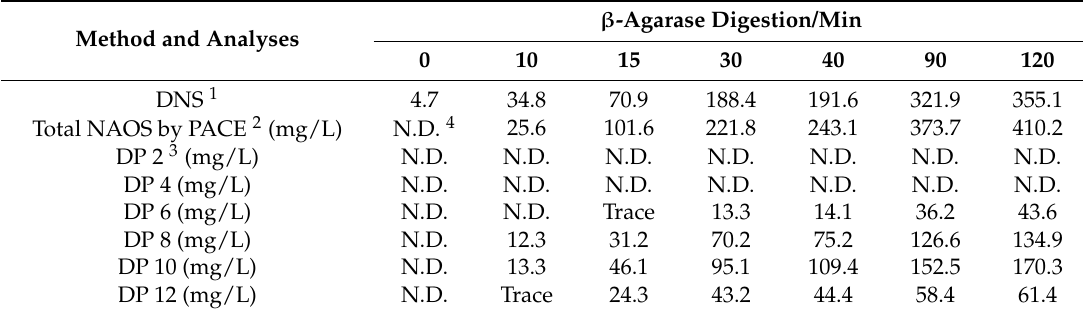
Table 3. Concentrations of neoagaro-oligosaccharides in different enzymatic time determined with PACE and